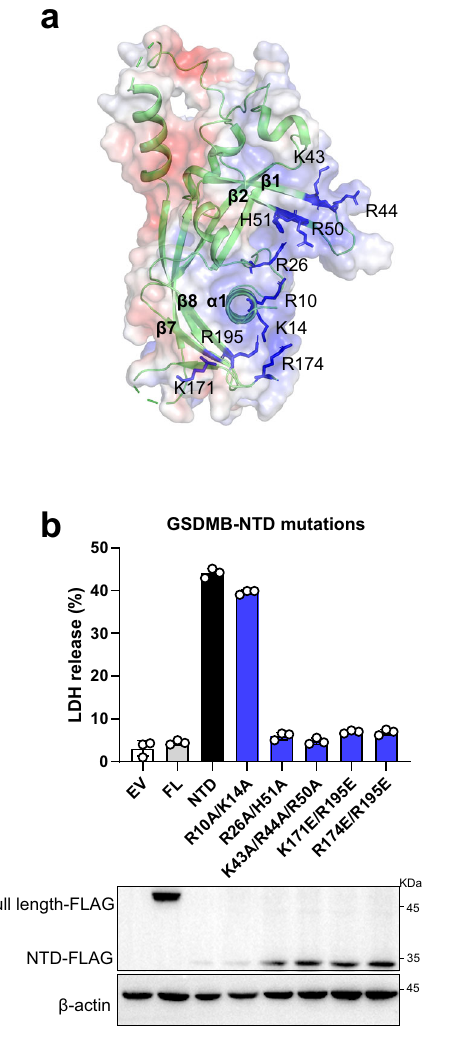
Fig. 3 | Pore-forming activityofGSDMB.a Electrostaticsurface representationof NTD-GSDMB. The basic residues are colored in blue and shown in stick repre- sentations. b Cell death was assessed by LDH cytotoxicity assay in HEK293T cells. Mutations of the basic residues in positively charged regions decreased the NTD- mediated LDH release. All experiments were repeated at least three times (mean±sd, n =3 independent biological replicates). Bottom, the expression levels